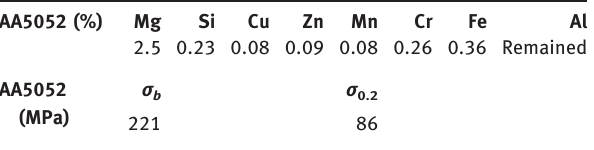
Table 3: Central composite rotatable design matrix. No. Welding parameters Laser power P